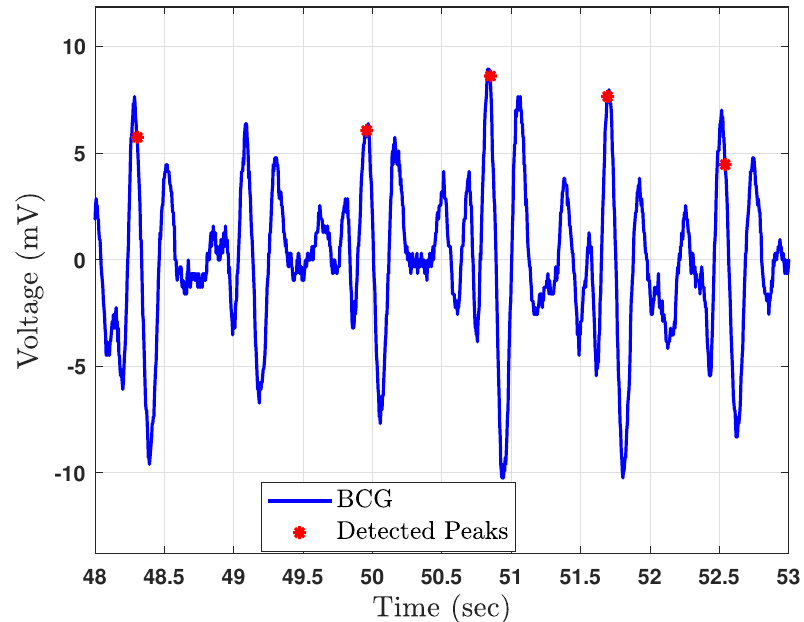
Figure 2. An example of perturbations in J − peak time estimates due to peak detection algorithm